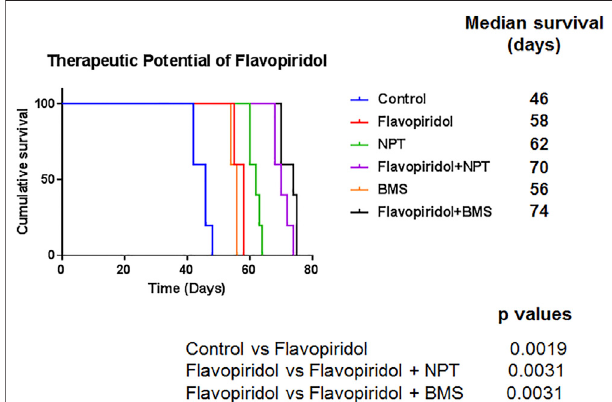
FIGURE 6 | Improvement in animal survival by fl avopiridol alone and by addition of chemotherapy or targeted therapy to fl avopiridol. Kaplan-Meier survival curve for NOD/SCID mice injected with high c-Myc expressing OE19 cells and treated with fl avopiridol alone (5 mg/kg in 100 µl of 0.1% DMSO, 5 times a week for 2 weeks) and in combinations with chemotherapeutic agent nanoparticle albumin-bound paclitaxel (NPT) (10 mg/kg in 100 µl of PBS, 2 times a week for 2 weeks) or IGF-1R/IR targeted agent BMS-754807 (BMS) (25 mg/kg in 100 µl of PBS, 5 times a week for 2 weeks) for 2 weeks. The curve represents the animal survival time from the beginning of therapy. Statistical group differences in survival time were calculated using the log-rank test (GraphPad Prism